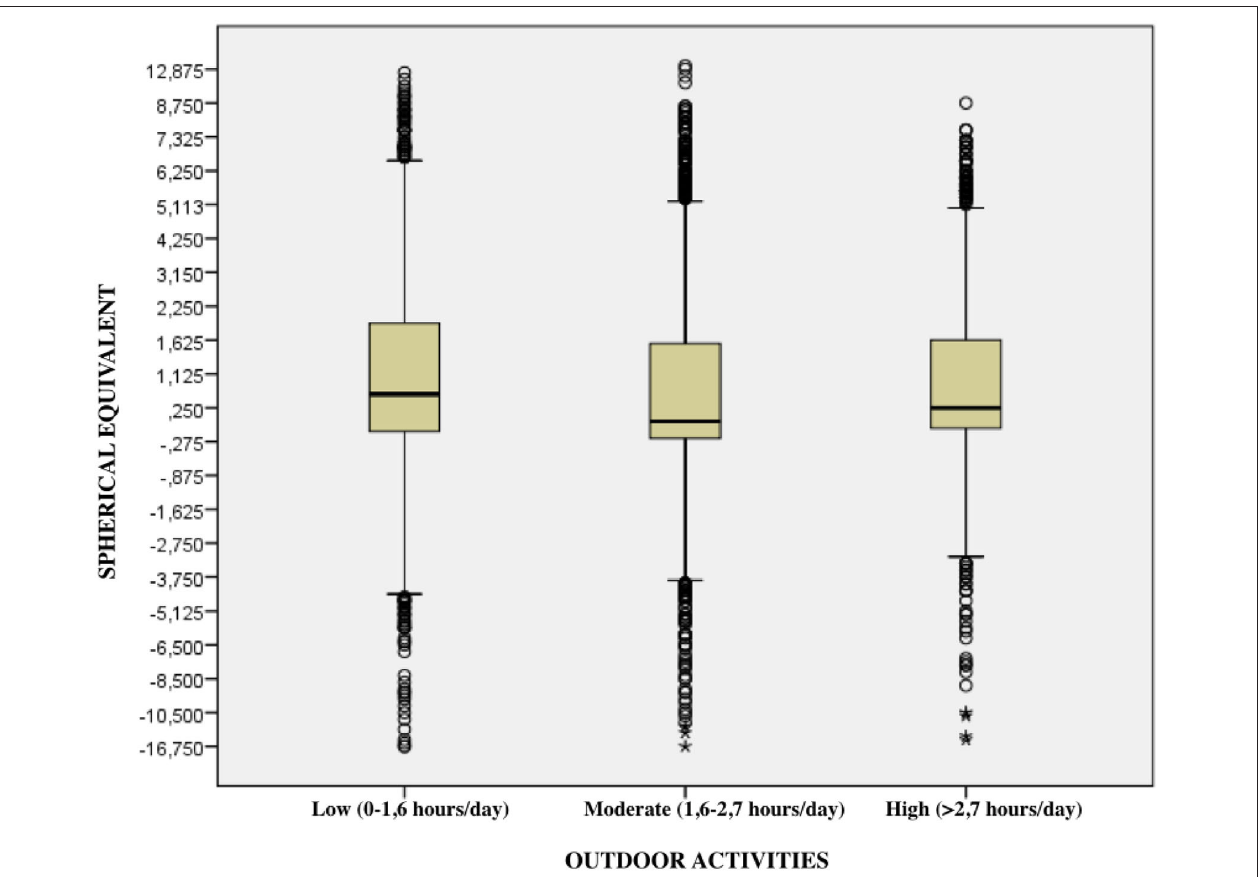
FIGURE 5 | Relationship between hours in outdoor activities and the magnitude of refractive